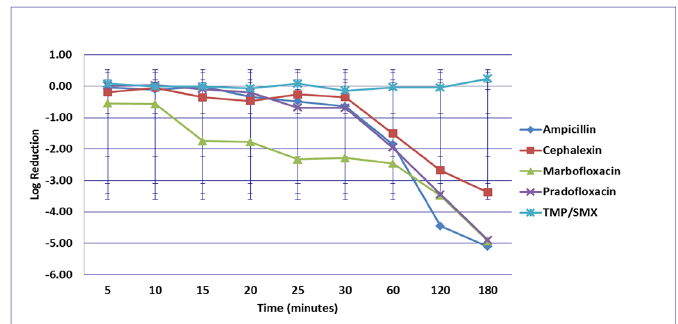
Figure 10. Log 10 reduction in P. mirabilis with bacterial cells exposed to ampicillin, cephalexin, mar- bofloxacin, and pradofloxacin at the mutant prevention drug concentration. Marbofloxacin vs. am- picillin at 15, 20, 25, and 30 min, p values from 0.0006 to 0.0214. Data points present mean ± standard deviation.